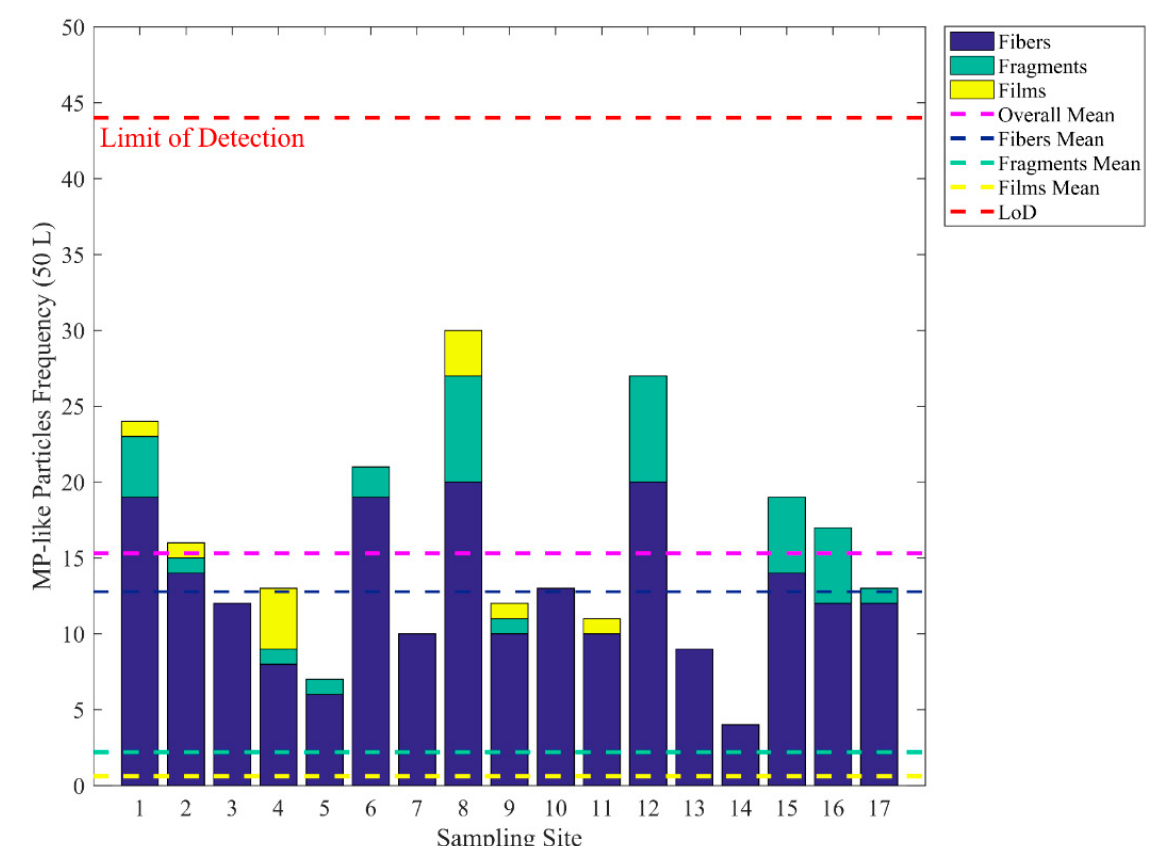
Figure 2. Number of MP-like particles > 100 µm identified by visual stereomicroscopy for each tap water sample. The results are categorised in relation to their type and the average results are also presented.